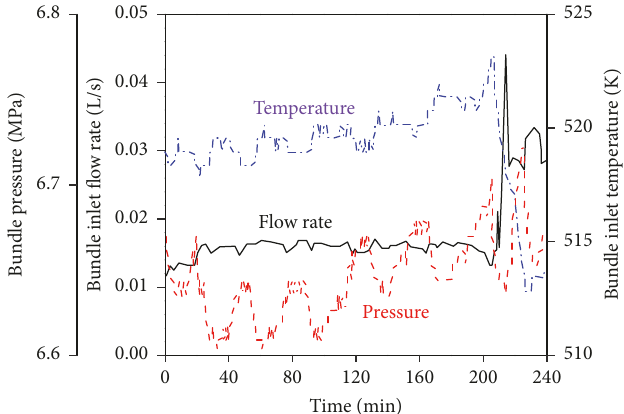
Figure 4: Boundary conditions used in the input code.